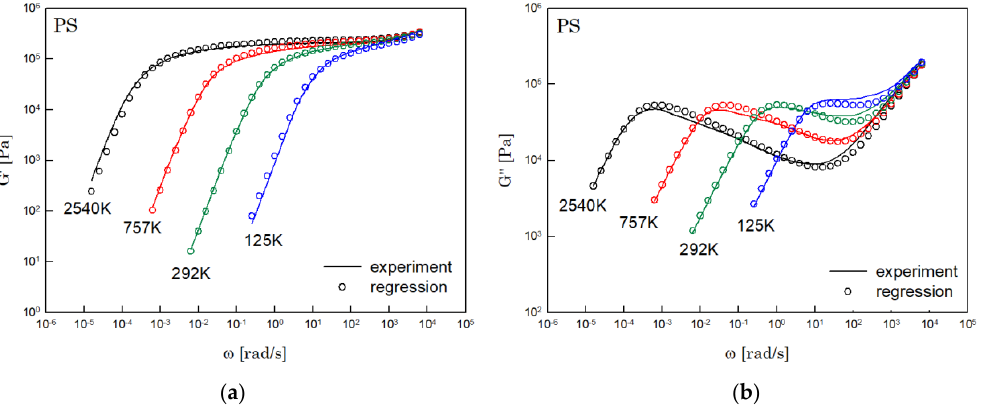
Figure 3. Comparison the regression results (lines) with the experimental data (symbols) of ( a ) storage modulus and ( b ) loss modulus of PS. These experimental data are measured by Schausberger et al. [15].